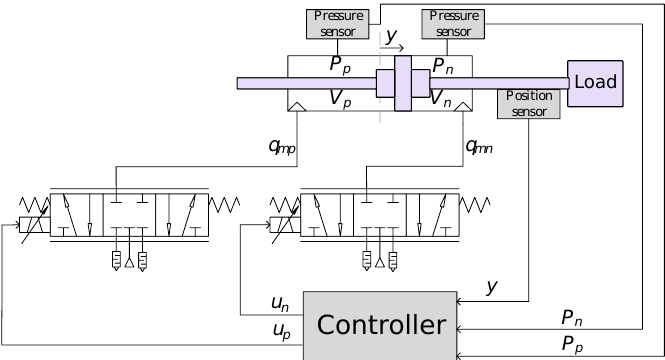
Figure 2. Electropneumatic